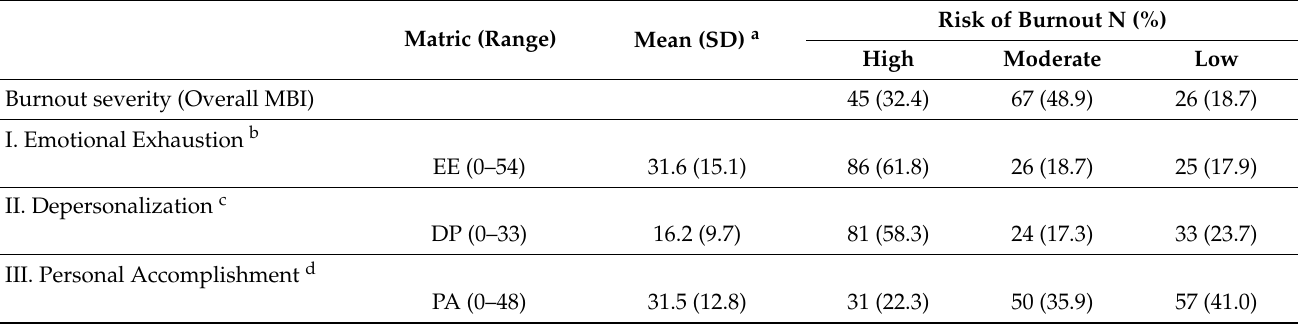
Table 2. Respondent Overall MBI Scores and Subscale Scores.